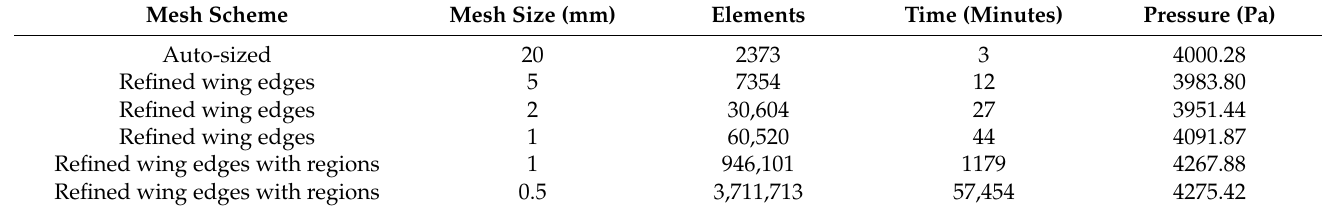
Table 6. Effect of Mesh Size on Pressure in the 2D Dimple Effect Analysis.